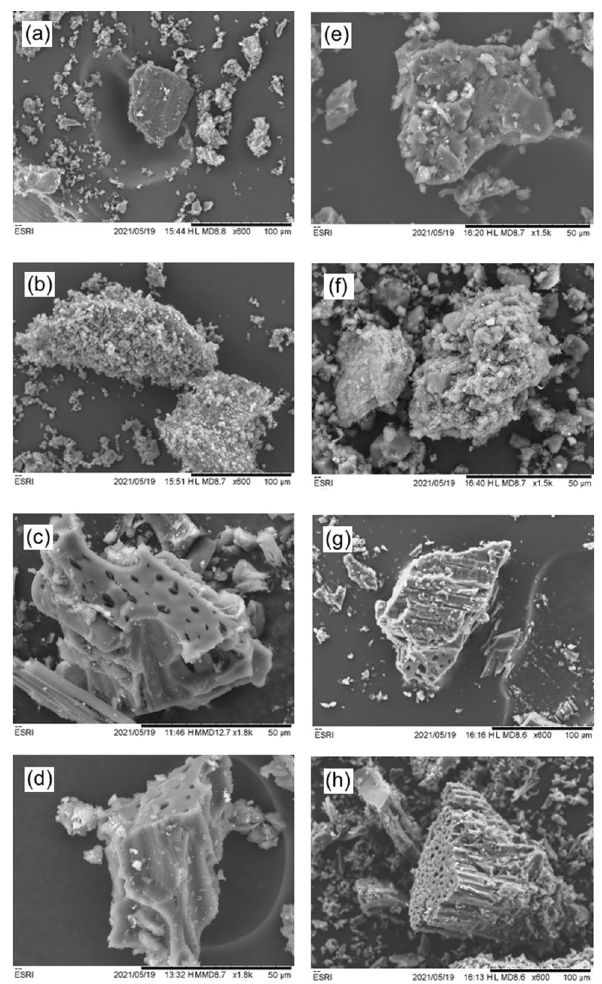
Figure 4. SEM images of samples of carbon and carbon/facemask melt blends. ( a ) GCI coal, ( b ) GCI coal with 20 wt.% facemask plastic, ( c ) charcoal, and ( d ) charcoal with 20 wt% added facemask plastic. ( e ) GCI coal after pyrolysis to 500 °C, ( f ) GCI coal with 20 wt.% facemask plastic after pyrolysis to 500 °C, ( g ) charcoal after pyrolysis to 500 °C, and ( h ) charcoal with 20 wt% added facemask plastic after pyrolysis to 500